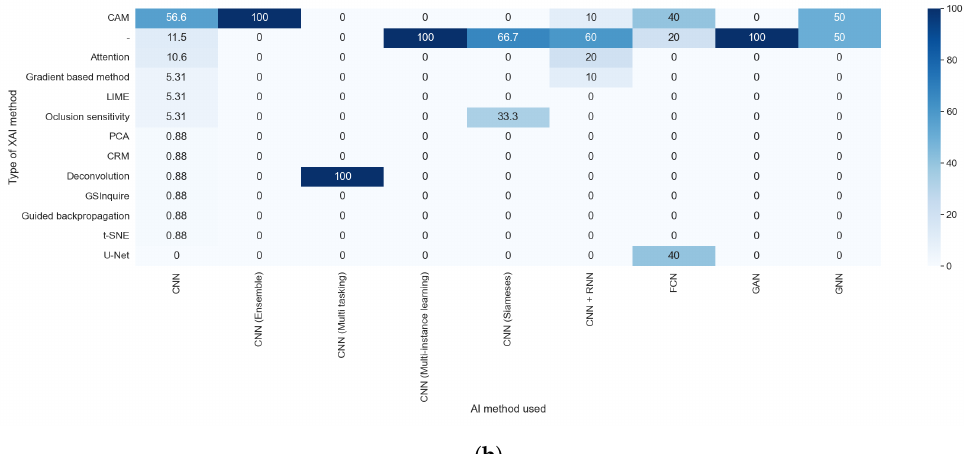
Figure 12. Heat maps comparing the results of RQ2 and RQ5. All articles that did not indicate the type of XAI method used are shown. ( a ) In absolute values; ( b ) normalized results by column.